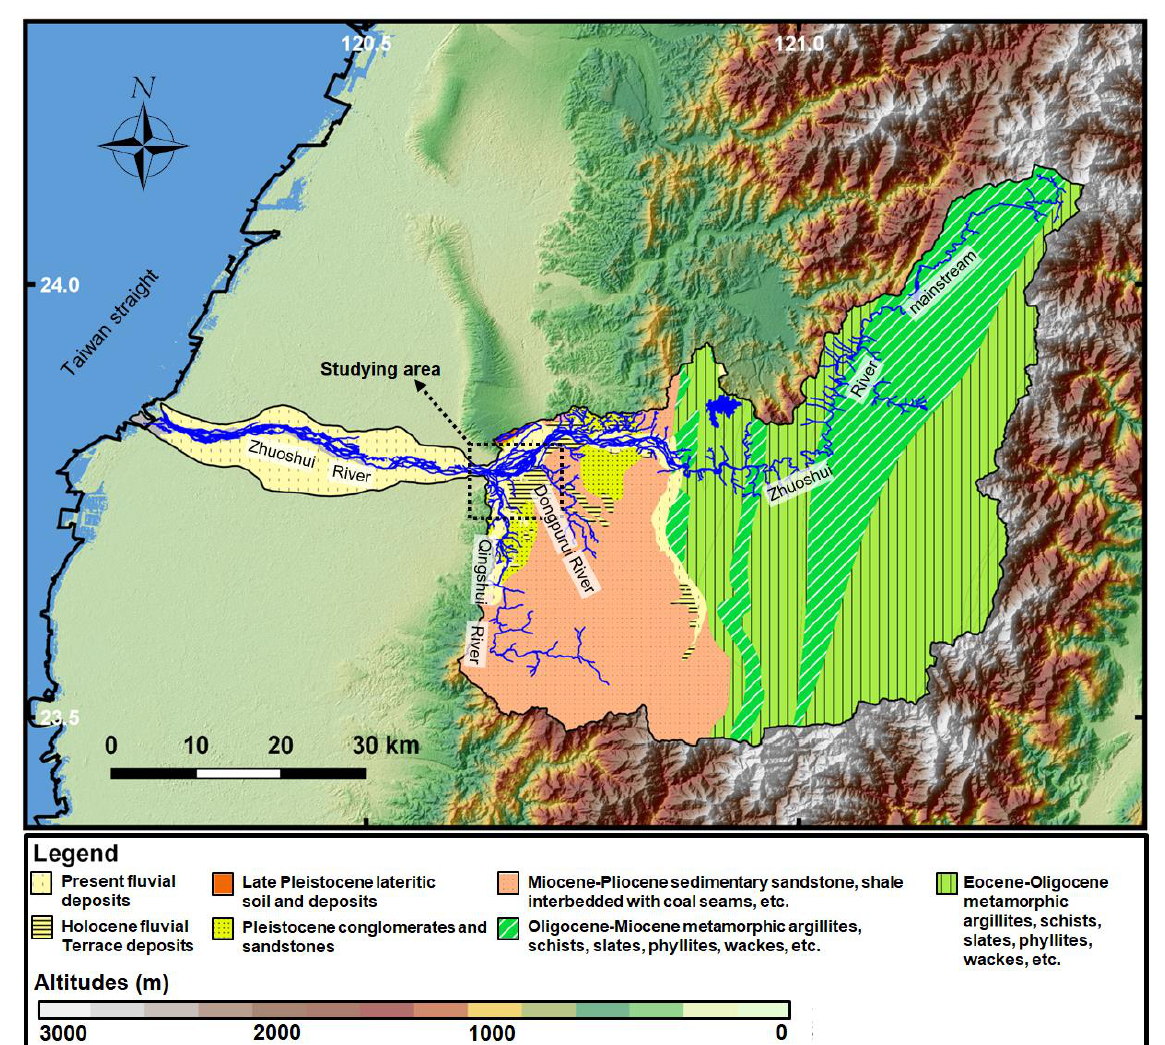
Figure 1. The Zoushui River flows through metamorphic rocks (e.g., argillite, schist, slate, phyllite) in upstream and sedimentary rocks (e.g., sandstone, shale, conglomerate) in the midstream. The mineralogical compositions of deposits by the mainstream upstream contain lots of slate fragments and debris. By contrast, those by the tributaries in the midstream (e.g., Qingshui River and Dongpurui River) contain sandstone or shale fragments with amounts of quartz grains.